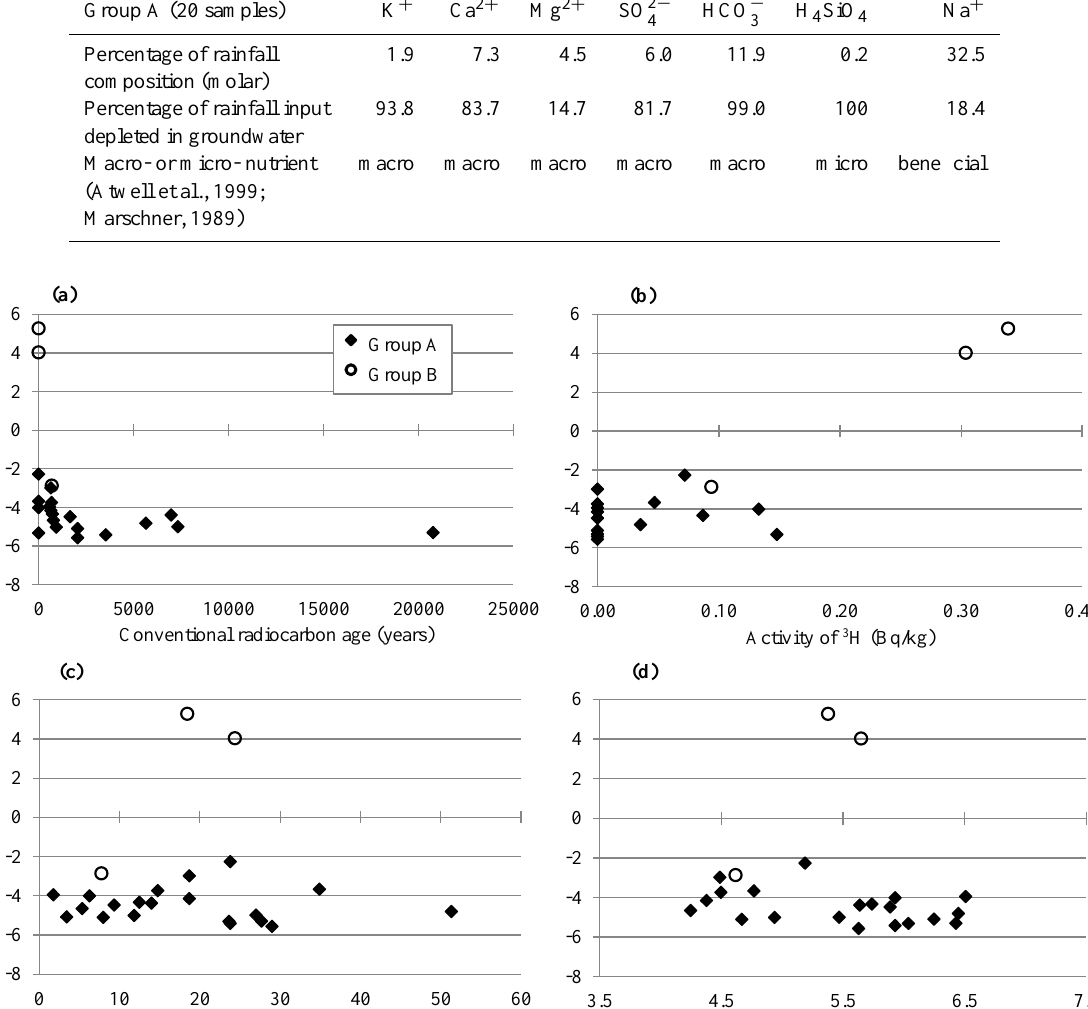
Table 9. Comparison of plant nutrient requirements with percentage species depletion in groundwater (calculated by dividing median rainfall composition by depletion values for Group A groundwater in Table 5).